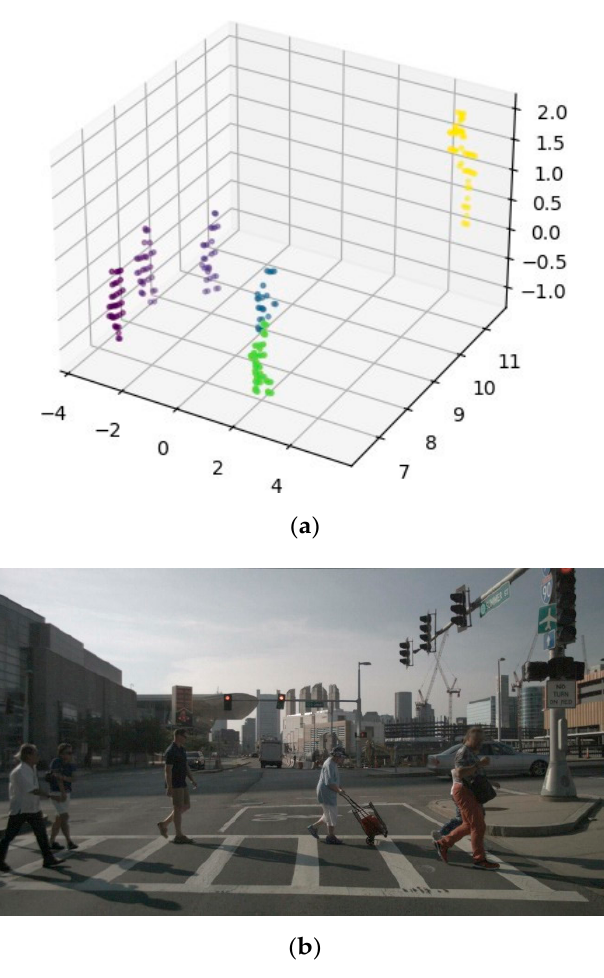
Figure 14. ( a ) Clustered objects defined via DBSCAN clustering. ( b ) Actual image.